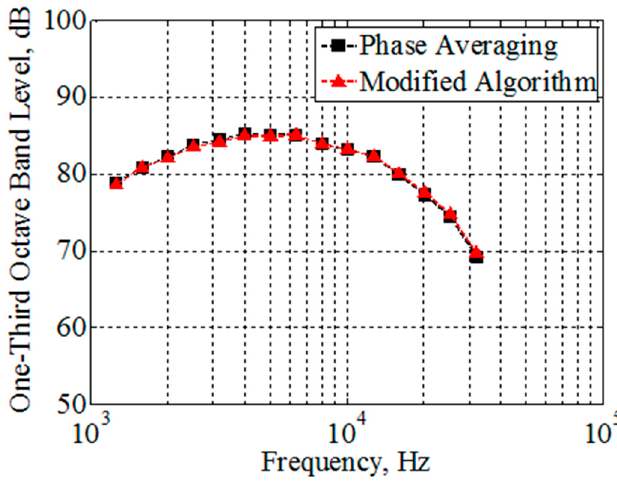
Figure 5. Comparison of one-third octave broadband spectra of single-shaft fan data.